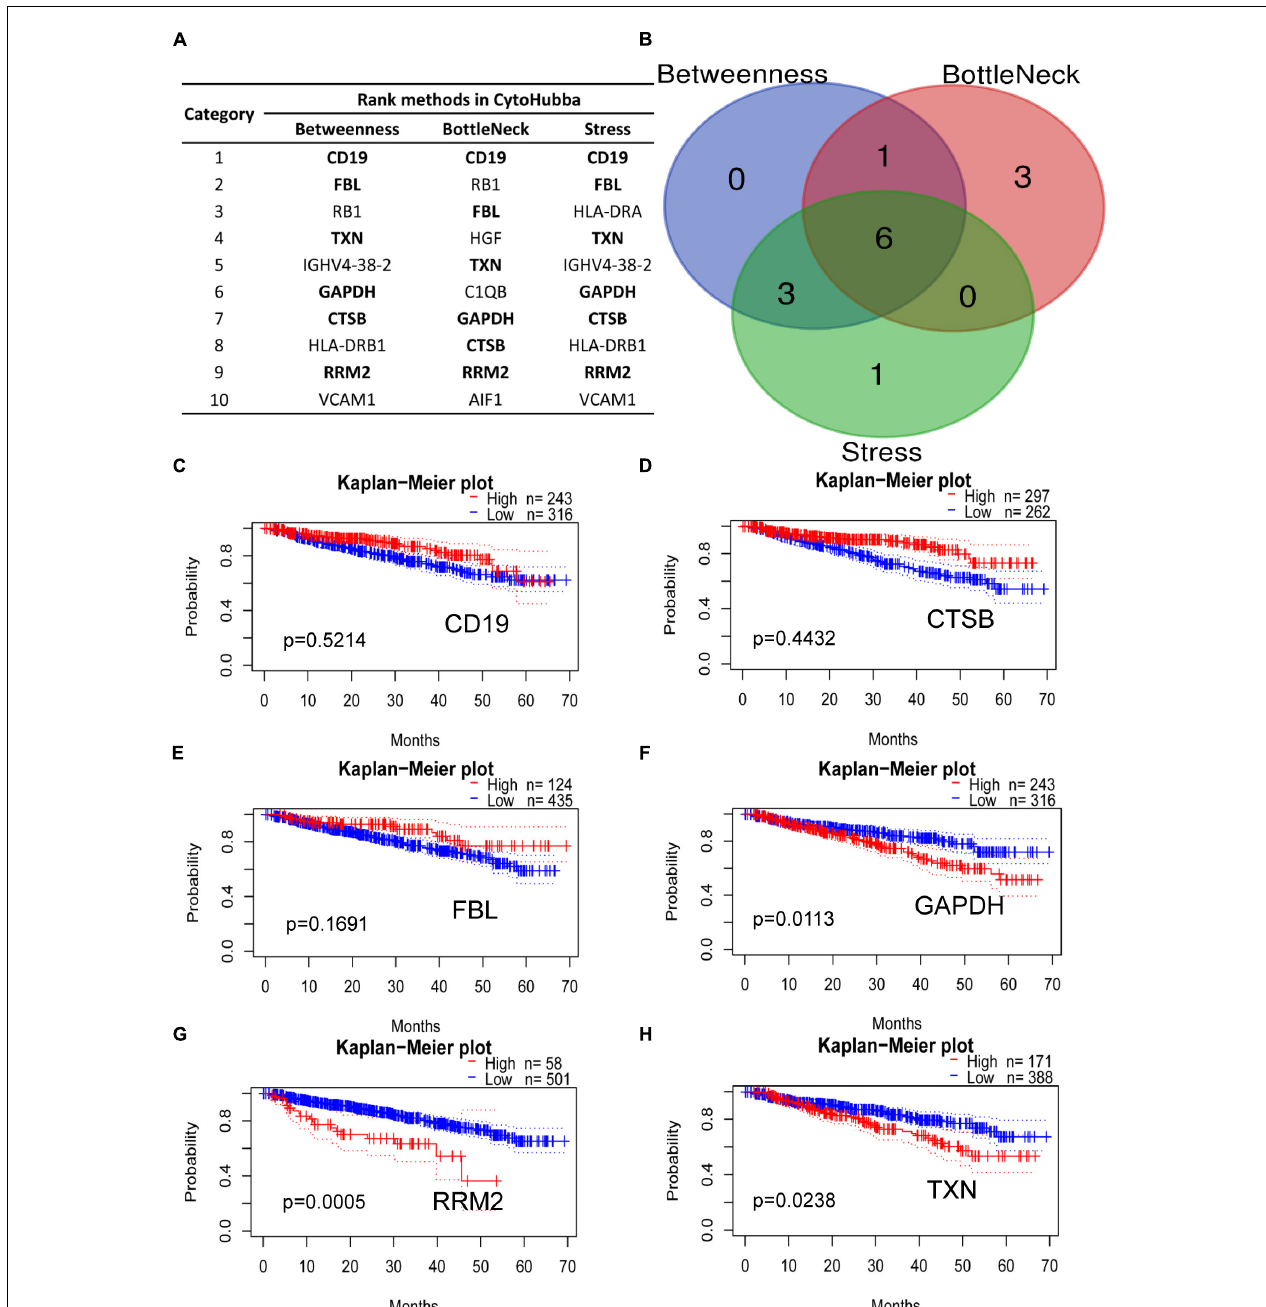
FIGURE 6 | Hub genes ranked by three CytoHubba methods. (A) Bold gene symbols were the overlap genes in top 10 by three ranked methods. (B) Overlapped six genes in Betweenness, Bottleneck, and Stress methods. (C–H) Kaplan–Meier analysis of CD19, CTSB, FBL, GAPDH, RRM2, and TXN correlated with MM